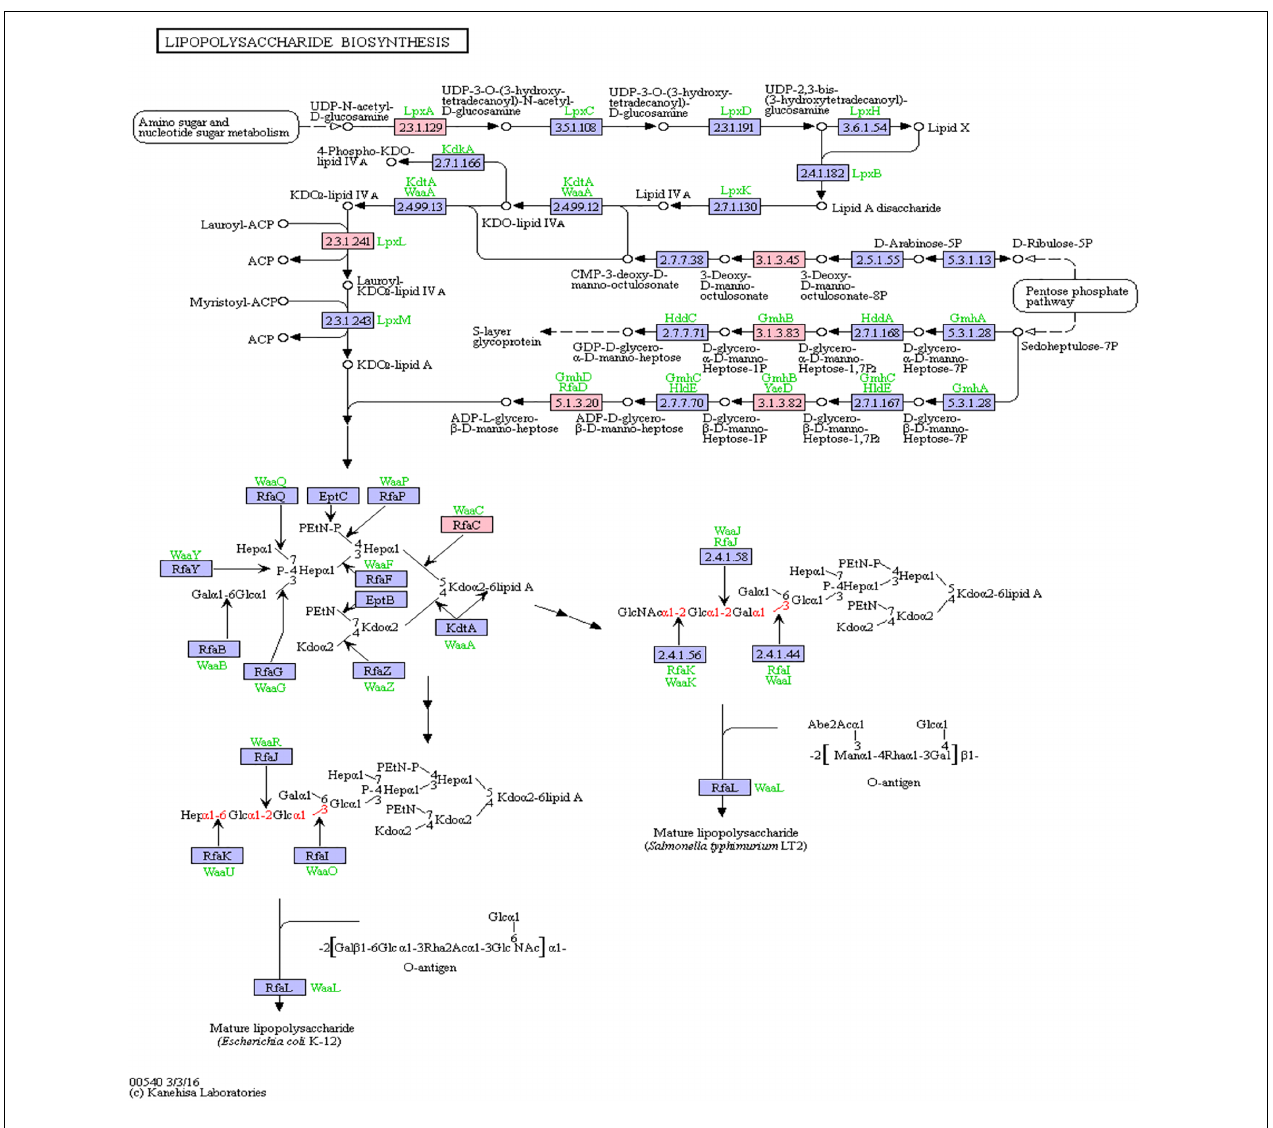
FIGURE 5 | Lipopolysaccharide Biosynthesis from KEGG. Proteins encoded by bacterial genome regions that revealed miRNA target matches are colored in pink.